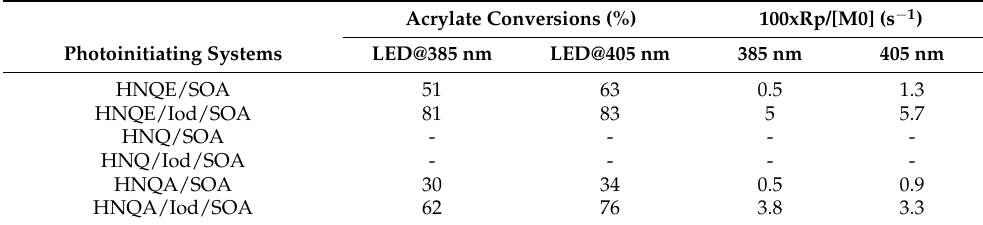
Figure 4. Kinetic profiles for the free-radical photopolymerization of SOA with the following initiating systems: ( A ) HNQA (0.5 wt%), ( B ) HNQE (0.5 wt%), ( C ) HNQA /Iod (0.5/2% w / w ), and ( D ) HNQE /Iod (0.5/2% w / w ) upon (1) LED@405 nm and (2) LED@385 nm in laminate. Table 5. Final acrylates conversions (determined by IR) in laminate upon LED@385 nm (44 mW/cm 2 ) and LED@405 nm (60 mW/cm 2 ) irradiation for 600s in the presence of HNQA (or HNQE ) (0.5 wt%) or HNQA (or HNQE )/Iod (0.5%/2%, w / w